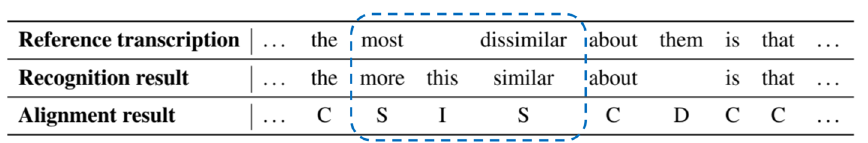
Fig. 2 Words sequence alignment result between a recognized utterance and its corresponding reference transcription. The dotted rectangle indicates the segment that is influenced by the utterance of an Out-of-Vocabulary (OOV) word